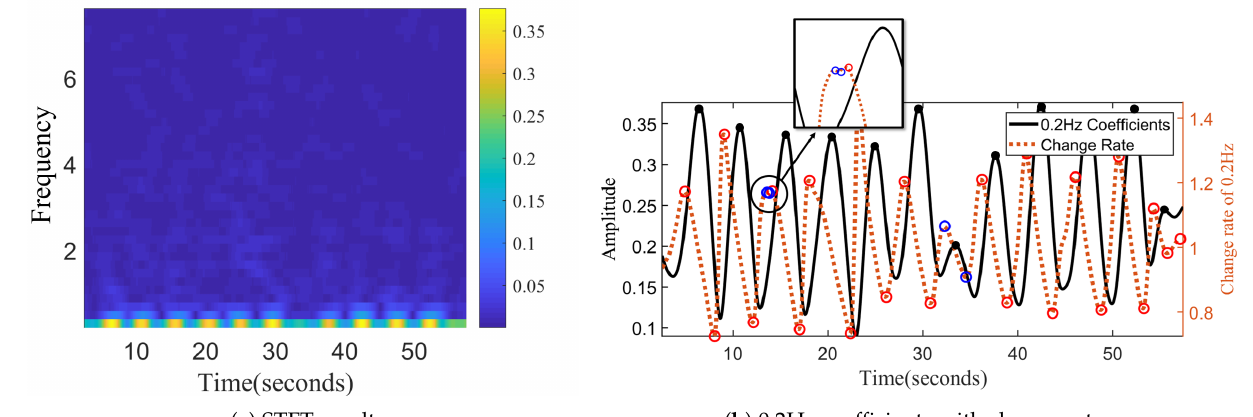
Figure 11. Spectrogram analysis for segmentation